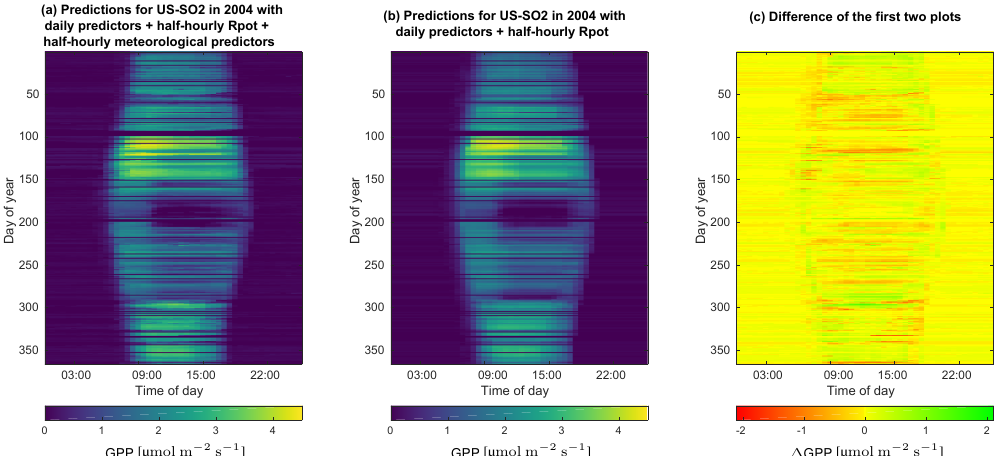
(c) Difference of the first two plots